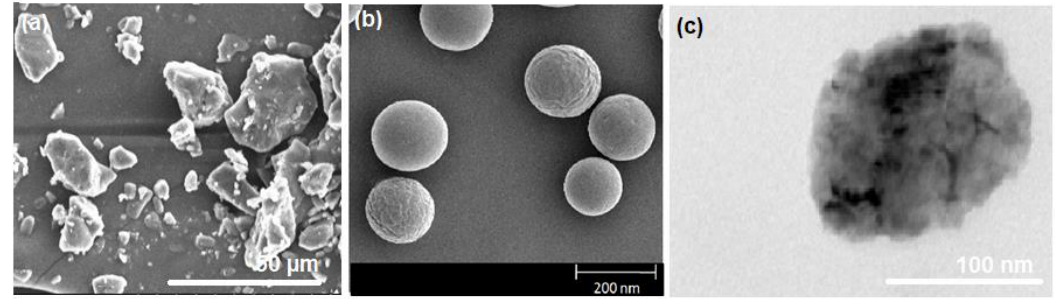
Figure 2. SEM image of ( a ) free MEM, ( b ) MEM-NC3, and ( c ) TEM image of MEM-NC3.